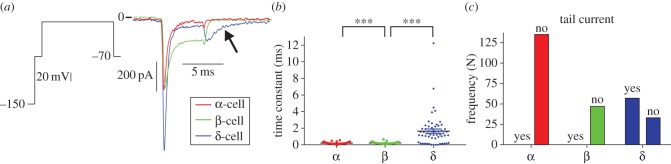
The presence of a slow Ca2+ tail current is a feature of δ-cells (not α-cells). (a) The presence of a slow tail current was characterized in each of the 288 cell recordings. (b) Following a test pulse to 30 mV, a slow tail current was present on the decay to −70 mV if the time constant of decay of the tail current was >1.5 ms. (c) The slow tail current was most prevalent in δ-cells. One-way ANOVA with Tukey's post hoc test (***p < 0.001). N = 141 α-cells, N = 56 β-cells and N = 91 δ-cells. (Online version in colour.)